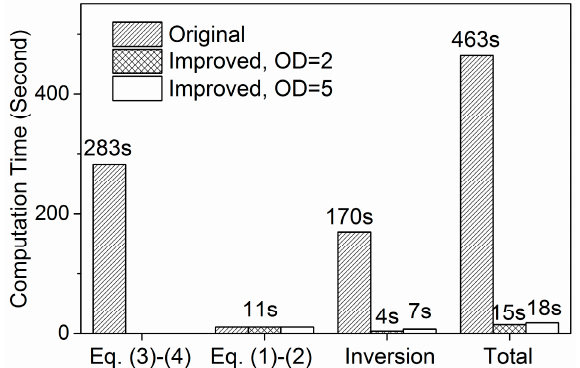
OD = 2) and 18 s (for OD = 5).